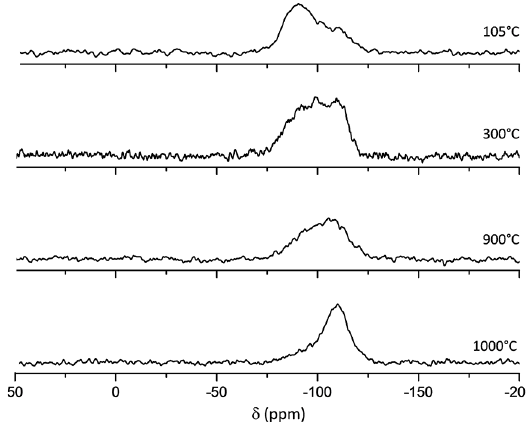
Figure 7. 29 Si NMR spectra of the synthetic aluminosilicate heat treated at 105 °C, 300 °C, 900 °C and 1000